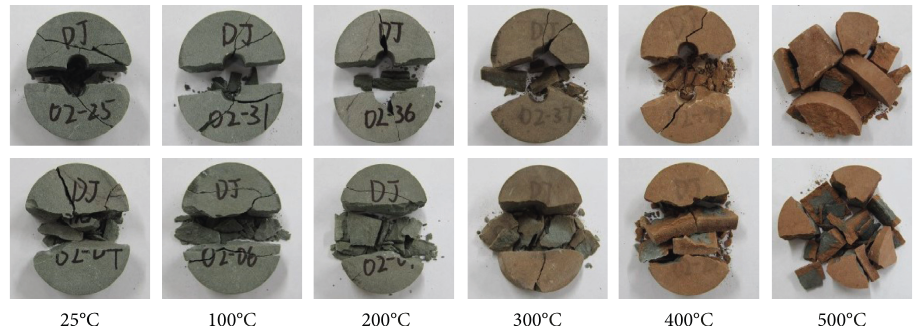
Figure 13: Failure modes of annular and intact sandstone specimens after different temperatures: (a) 25 ° C, (b) 100 ° C, (c) 200 ° C, (d) 300 ° C, (e) 400 ° C, and (f) 500 °